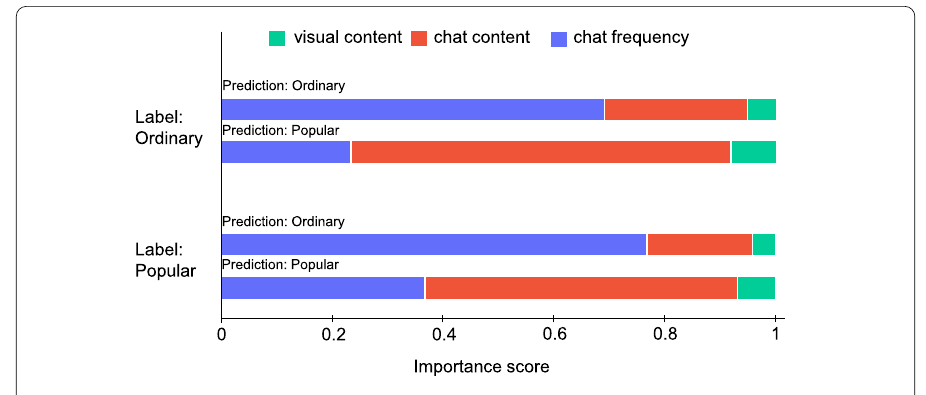
Figure 7 Importance score by the view count groups and prediction result. Popular clips have a greater importance score of chat-content and a small importance score of frequency than ordinary clips. The importance score of visual features has less difference than other factors